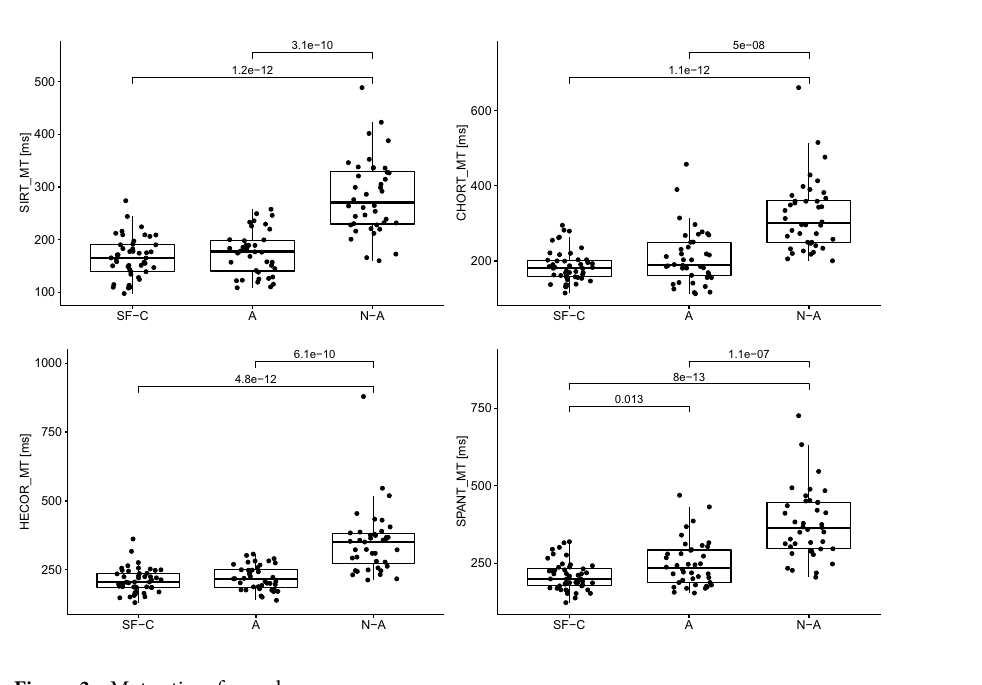
Figure 3. Motor time for each